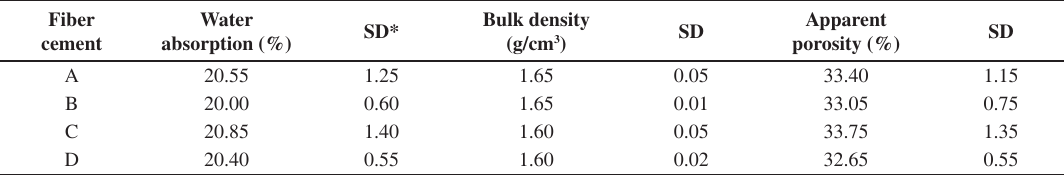
Table 10. Physical characteristics at 28 days of age.